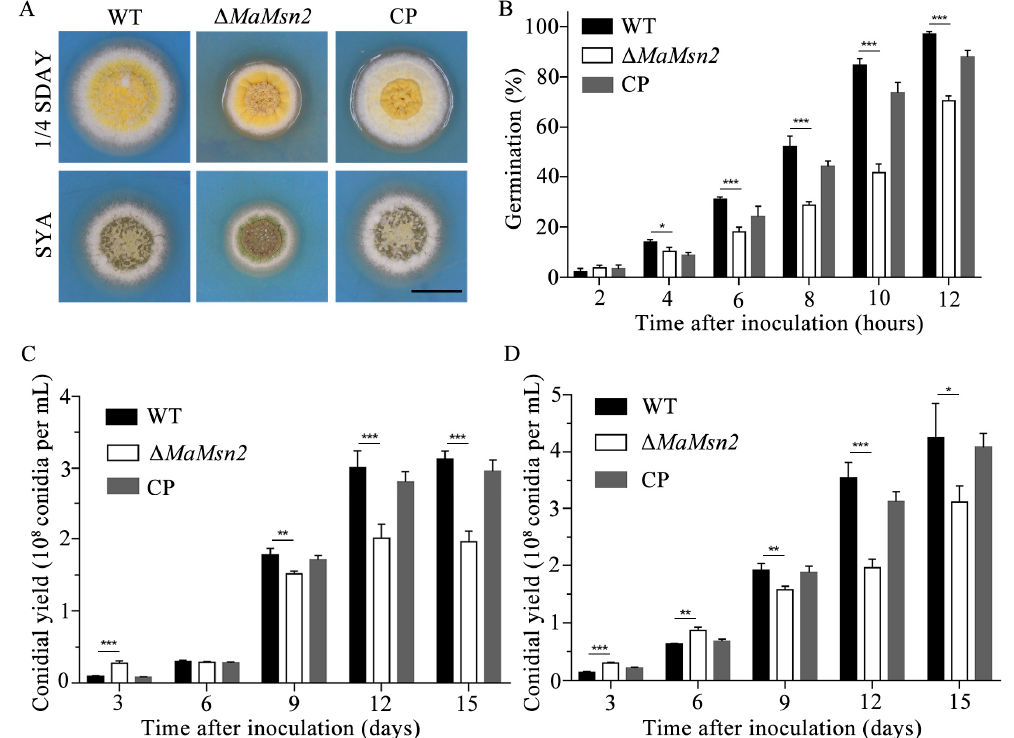
Figure 2. Growth and conidiation analysis. ( A ) The colonies of ∆ MaMsn2 grown on 1/4 SDAY and SYA media for 5 days. The scale bar indicates 1 cm. ( B ) Conidial germination rate of ∆ MaMsn2 for 2, 4, 6, 8, 10 and 12 h. ( C , D ) Conidial yields of ∆ MaMsn2 at 3, 6, 9, 12 and 15 days on 1/4 SDAY ( C ) and SYA ( D ). ( t -test, *: p < 0.05, **: p < 0.01, ***: p < 0.001).